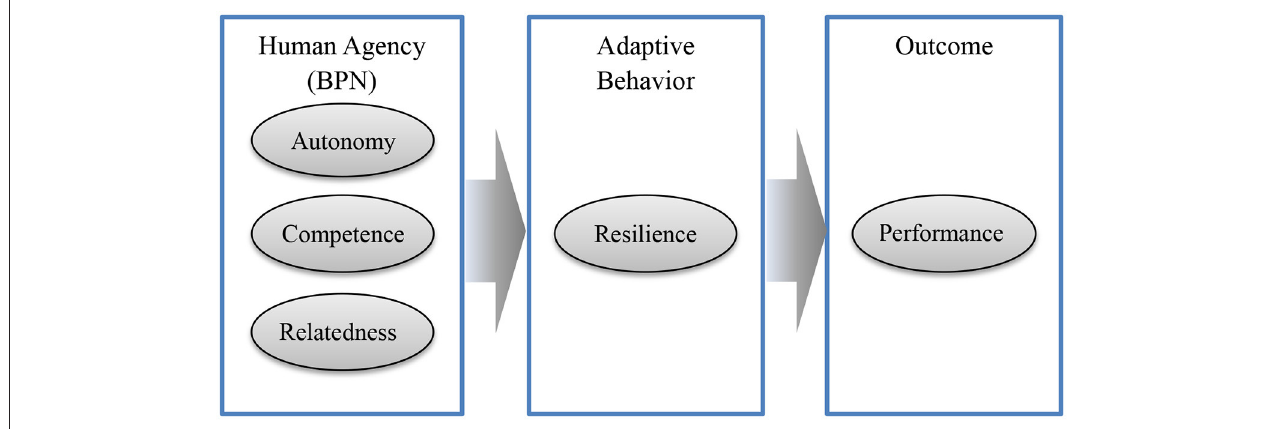
FIGURE 1 | A theoretical framework of the mediation role of resilience from human agency to academic performance. BPN, basic psychological needs.